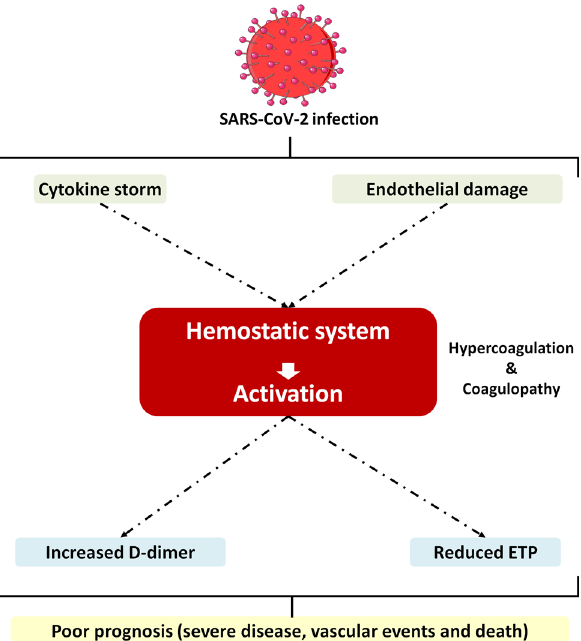
Figure 4. Schematic representation of potential insults associated to SARS-CoV-2 infection and the consequences on the hemostatic system. The drawing is a modified version of an image available in Servier Medical Art templates, which are licensed under a Creative Commons Attribution 3.0 Unported License; https:// smart. servi er.